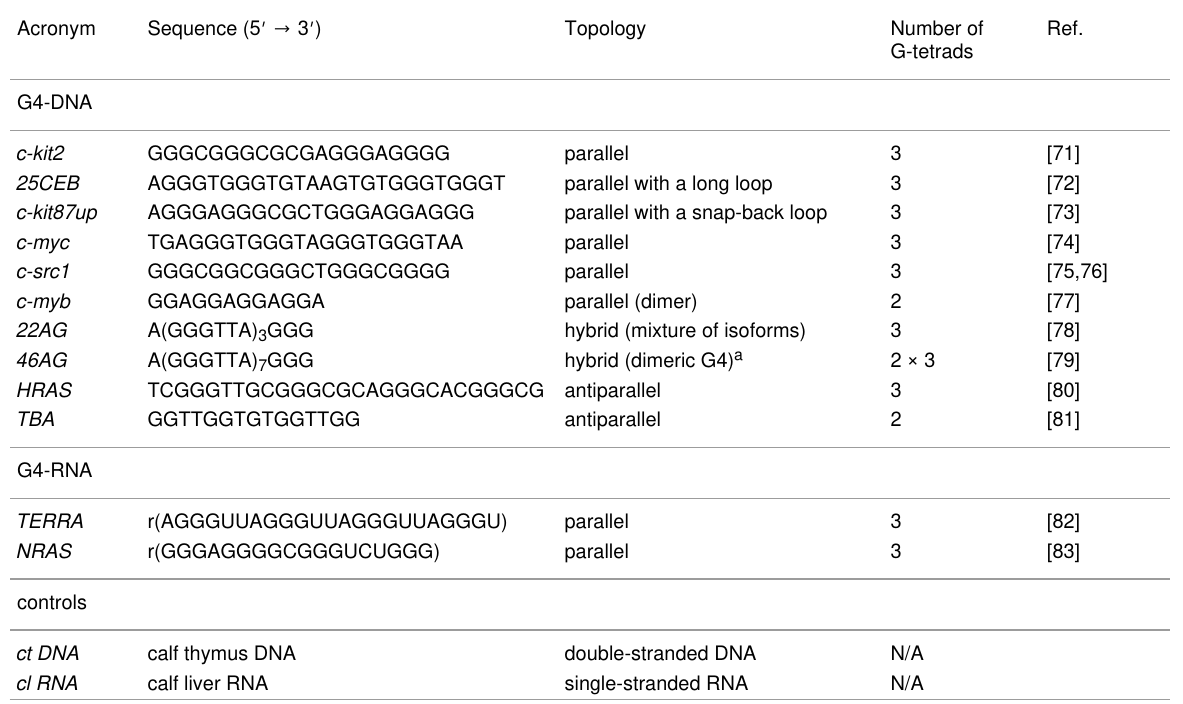
Table 2: Nucleic acid samples used in the first screening